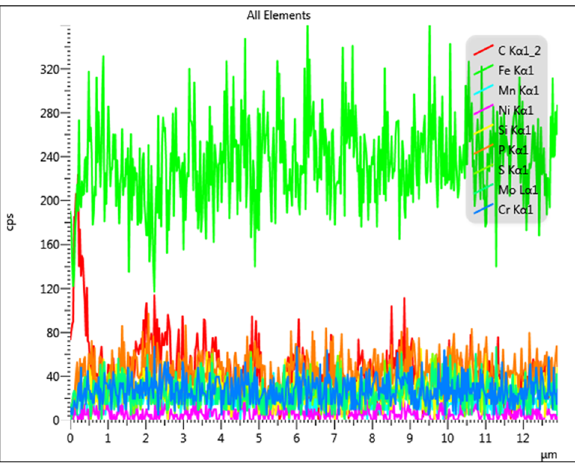
Figure 6: FESEM - EDX line scanning analysis along the thickness of the 0 – 13 µm in sample